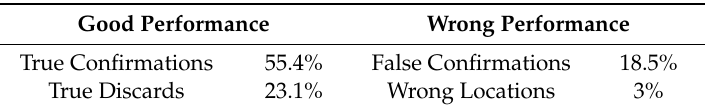
Table 3. Detection performance over the dataset in Table